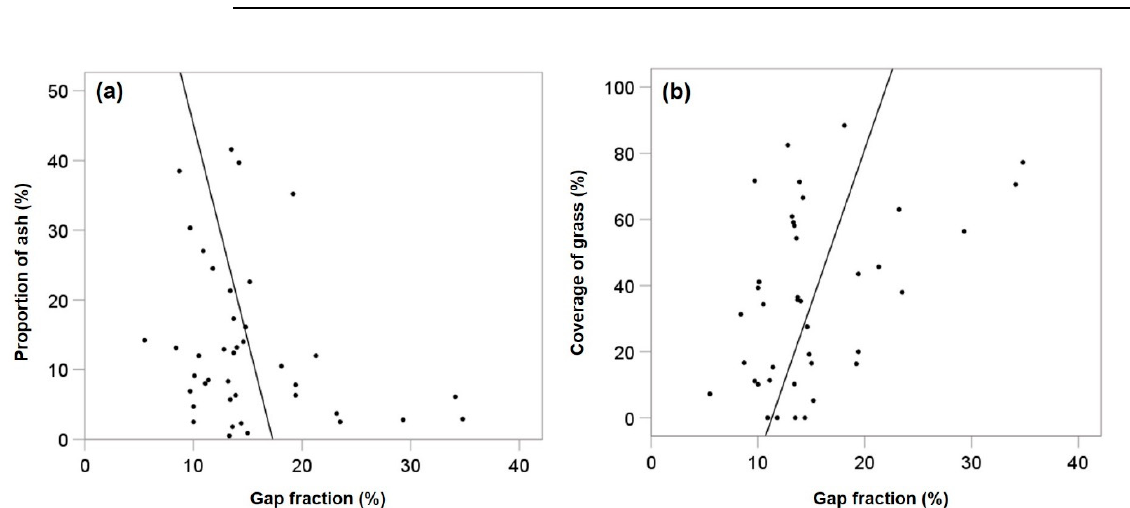
Figure 2. Scatterplot visualisation of the relationships between gap fraction and proportion of ash ( a ) and coverage of grass ( b ).